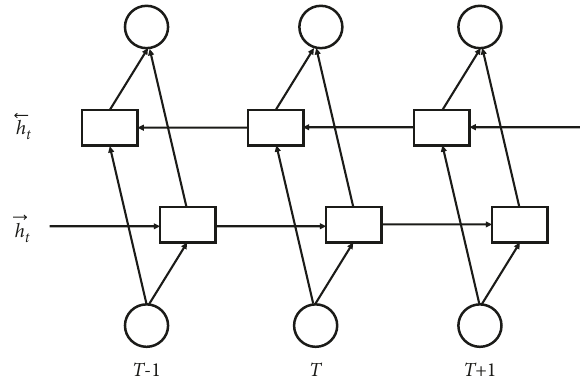
Figure 3: Structure of